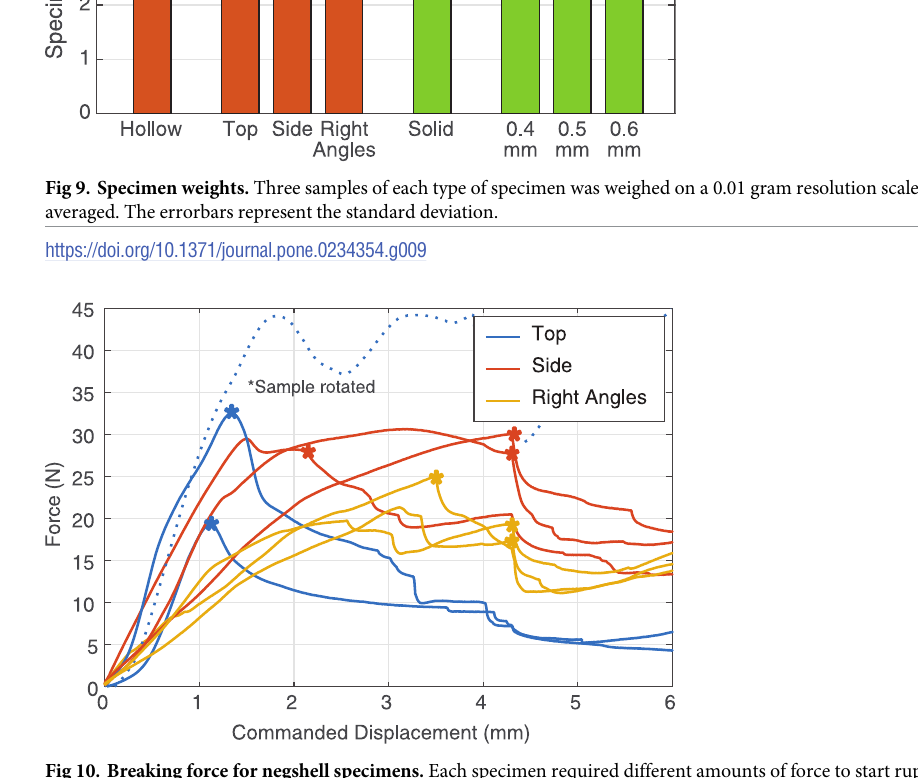
Fig 10. Breaking force for negshell specimens. Each specimen required different amounts of force to start rupturing, as denoted by the asterisks that precedes a sharp decline in force reading.